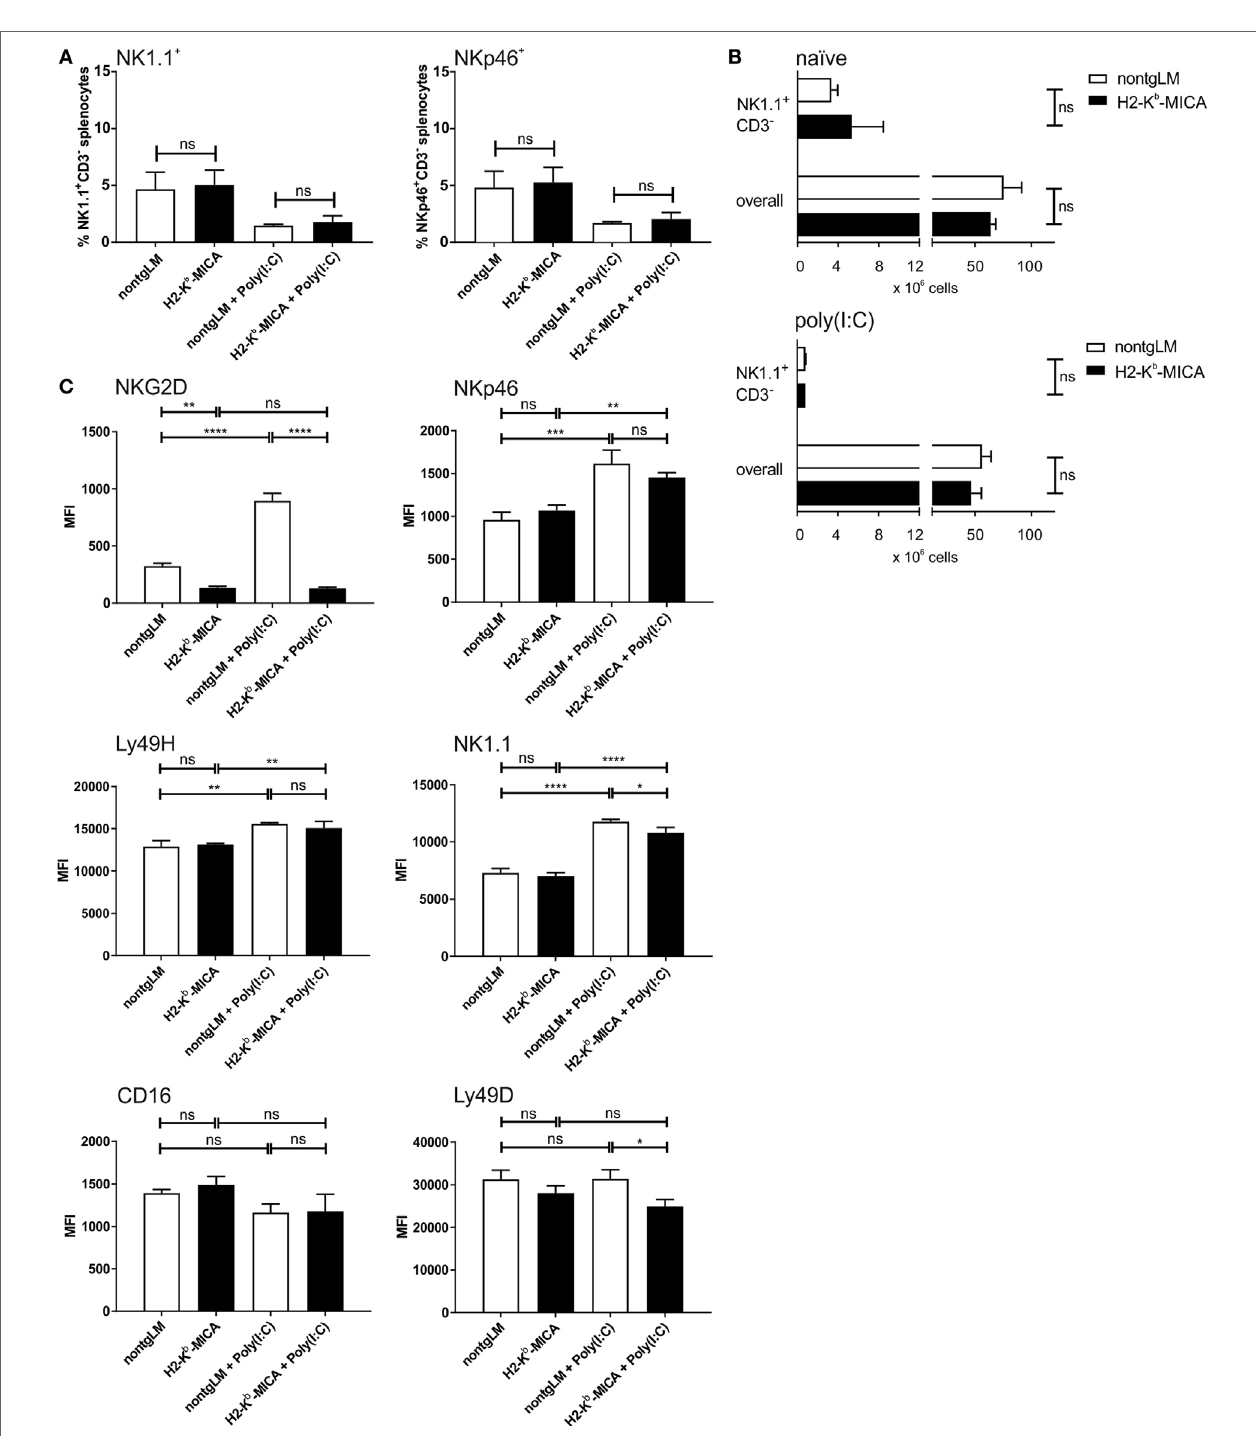
FigUre 1 | Reduced NK cell surface expression of NK1.1 and Ly49D in mice with enforced ligand-induced NKG2D downregulation. Numeric and phenotypic assessment of NK cells from H2-K b -MICA mice by flow cytometry. Splenic NK cells were isolated either from naïve mice or 16 h after poly(I:C) injection (activated NK cells). (a,B) No significant differences in frequencies (a) or total numbers (B) between resting or activated splenic NK cells from H2-K b -MICA mice and non-transgenic littermates (non-tgLM). NK cells were gated as NK1.1 + CD3 − splenocytes, and in panel (A) also as NKp46 + CD3 − splenocytes. Data show means plus SE from three mice analyzed in parallel. One representative out of at least three independent experiments is shown. A two-way ANOVA was performed with a Sidak posttest. (c) Surface expression of activating receptors NKG2D, NKp46, Ly49D, Ly49H, NK1.1, and CD16 on splenic NK cells from naïve or poly(I:C) injected H2-K b -MICA mice versus non-tgLM. Data show means plus SDs from three mice analyzed in parallel. One representative out of at least three independent experiments is shown. Two-way ANOVA was performed with a Tukey posttest to assess statistical significance of differences (ns = not significant).